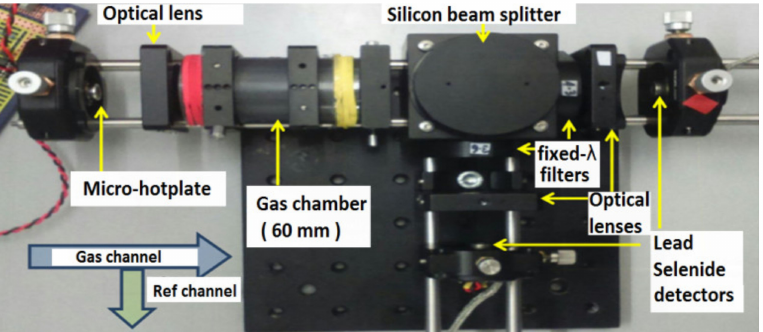
Figure 5. The demonstrator utilizing two single-element lead selenide detectors for the gas and reference